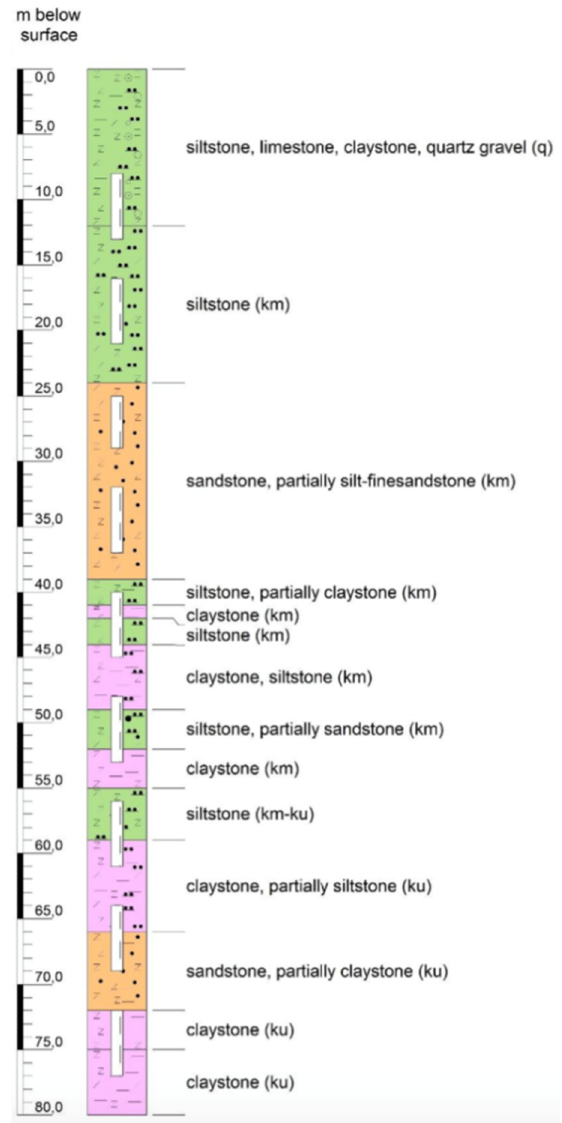
Figure A2. Well profile for well M [50].